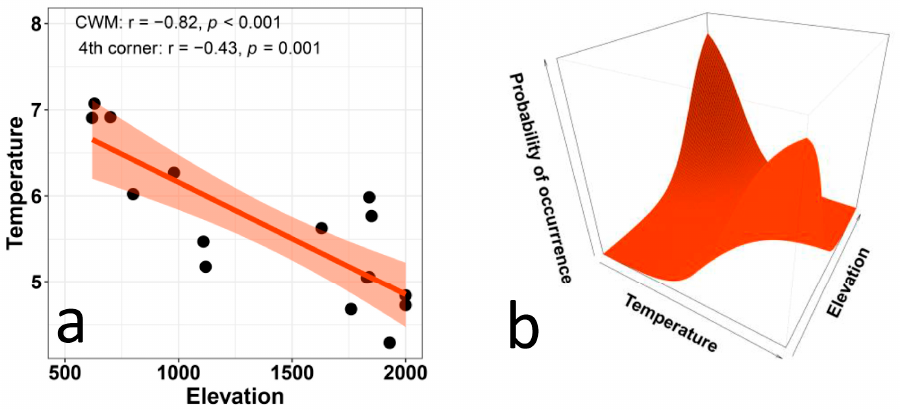
Figure 1. Relationship between Ellenberg indicator values for temperature and elevation in plant communities along an elevational gradient in Central Italy. The left panel ( a ) presents the CWM regression model and statistical corrections based on the fourth-corner analysis. The right panel ( b ) presents the results of the multi-level model (trait × environment interaction p < 0.001, marginal R 2 = 0.06).